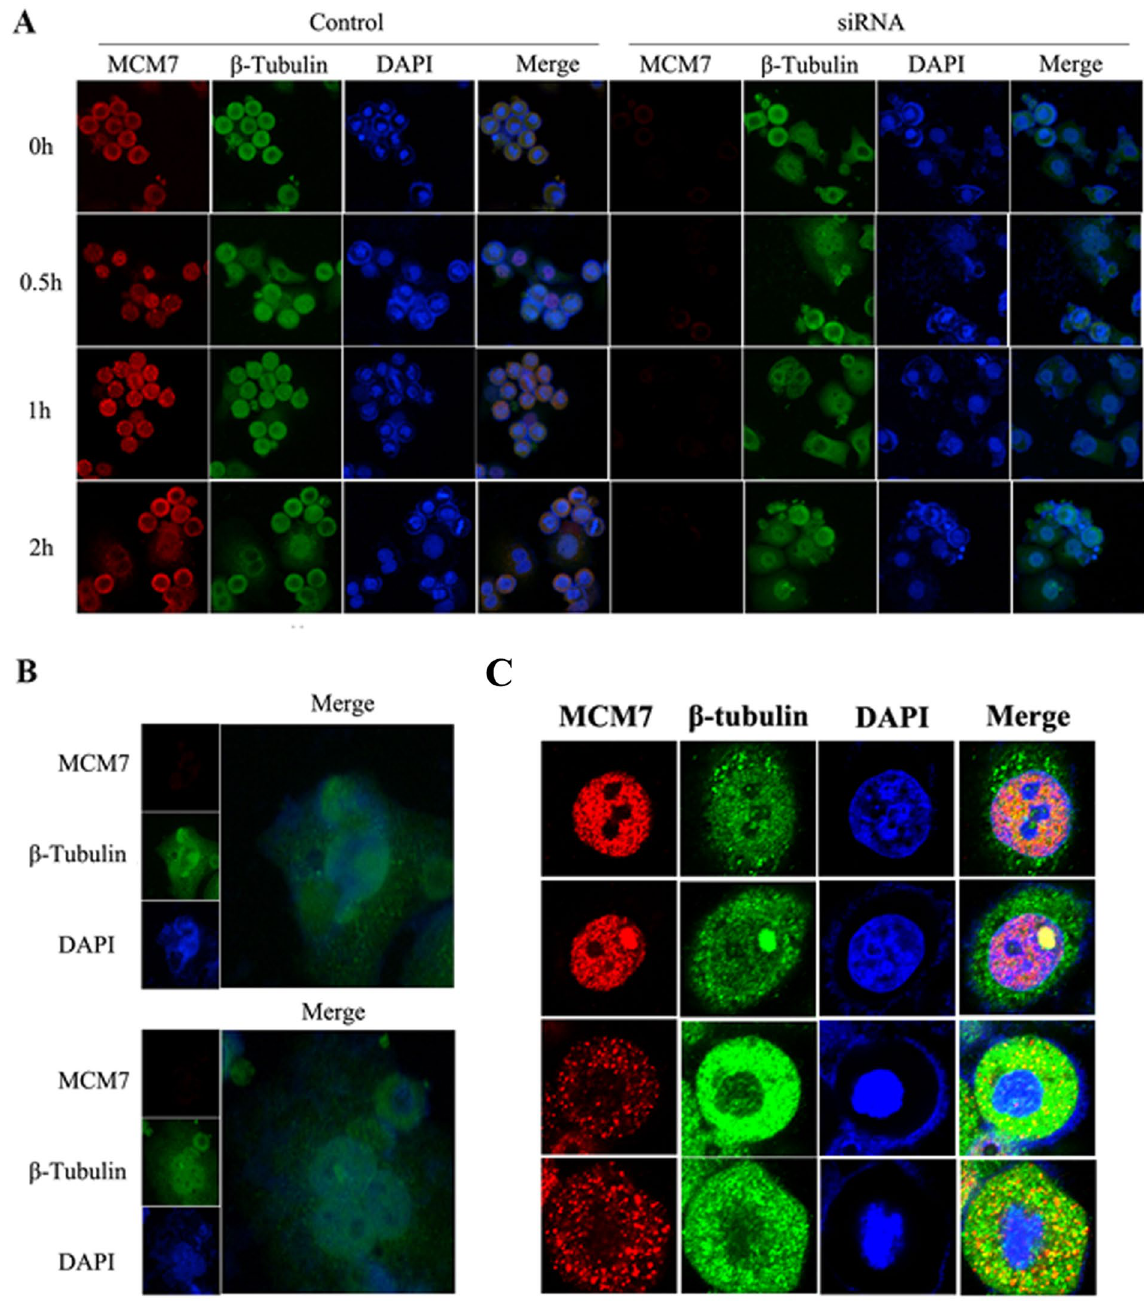
Figure 6. MCM7 depletion contributes to aberrant mitosis. ( A , B ) HepG2 cells were transfected with MCM7 siRNA or negative control siRNA. After being transfected for 12 h, cells treated with 0.2 μ g/ml nocodazole for further 12 h and then incubated in fresh medium for 0 h, 0.5 h, 1 h and 2 h. Immunofluorescence staining was performed to detect MCM7 (red) and β -Tubulin (green) in the cells, and nucleuses were visualized by DAPI staining (blue). ( C ) HepG2 cells were treated with or without 0.2 μ g/ml nocodazole for 12 h to block cell in M phase, above immunofluorescence staining was performed and observed under confocal